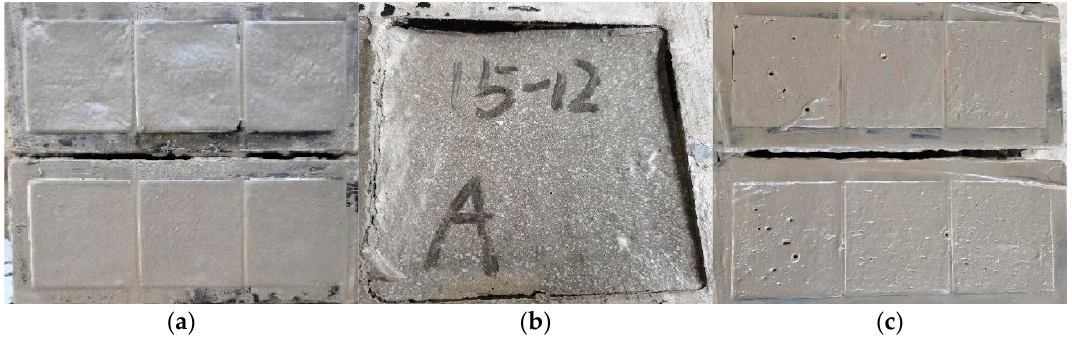
Figure 7. ( a ) The foam concrete with the best ratio has good stability; ( b ) The foam concrete slurry with water cement ratio of 0.6 segregates and bleeding leads to collapse; ( c ) The water-reducing agent is 0.2, and the foam concrete bubbles merge and float up. Table 7. Foundation mix ratio and properties of foam